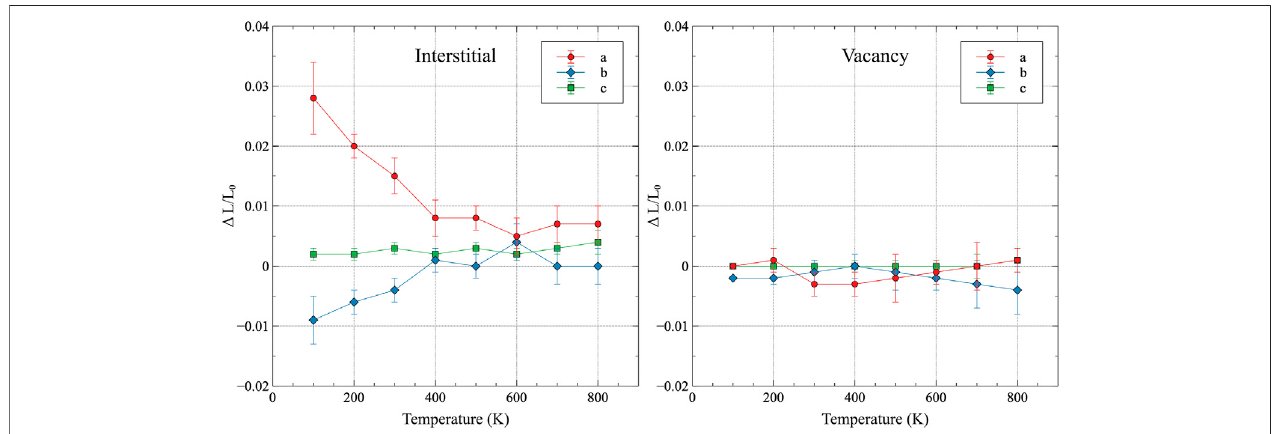
FIGURE 7 | The lattice strain induced from an interstitial or vacancy in α -U as a function of temperature, taken with respect to the equilibrium volume at that given temperature. Error bars indicate twice the standard deviation of the dataset.